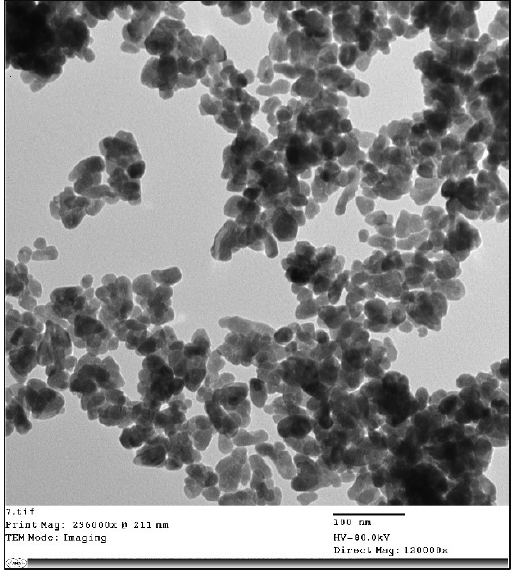
Figure 2. Transmission electron microscopy (TEM) micrograph of ZnO NPs.